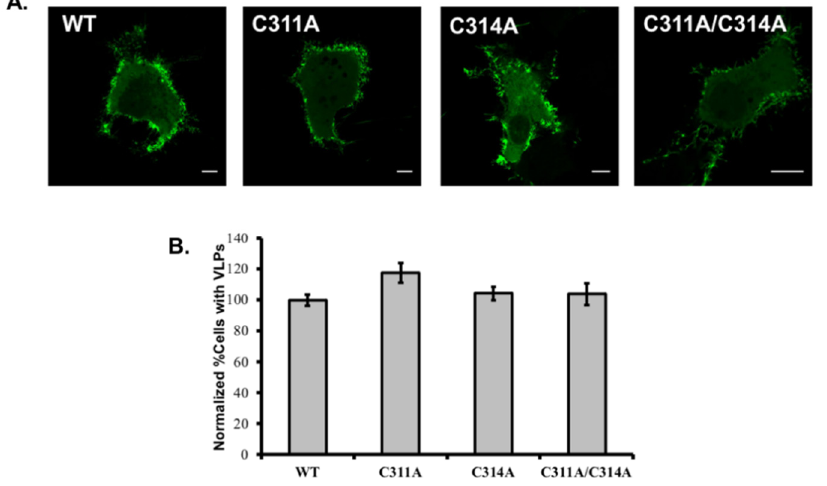
Figure 3. EGFP-VP40 and VP40 cysteine mutants cell phenotype. ( A ) Representative images of EGFP-VP40-WT, EGFP-VP40-C311A, EGFP-VP40-C314A and EGFP-VP40-C311A/C314A 12–14 h post transfection in COS-7 cells. Scale bars are 10 μ m. ( B ) Cell populations expressing pre-VLPs, data was normalized to 100% for cells expressing EGFP-VP40-WT with detectable VLPs to more easily differ an increase (or not) in VLPs by each mutation. Bars represent the average value over three independent experiments and error bars represent ± standard error of the mean.